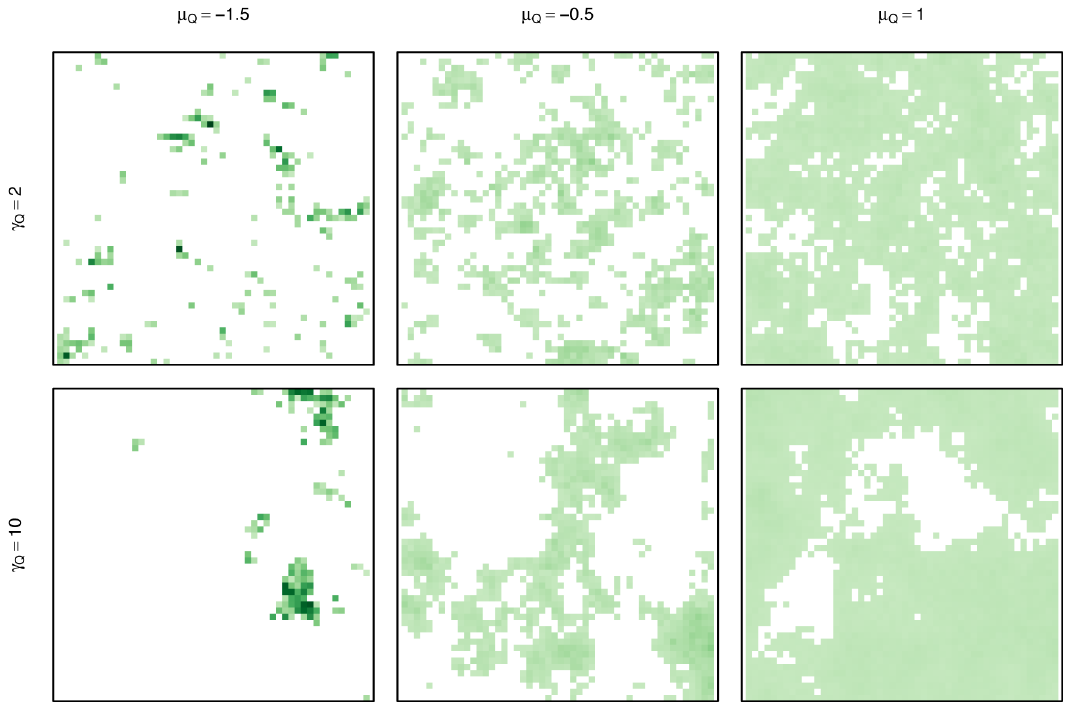
Fig 1. Sample generated landscapes for different combinations of patch concentration from patchy to smooth and patch size from small to large. Color indicates resource quality from none (white) to low (light green) to high (dark green). Total resources in each landscape are the